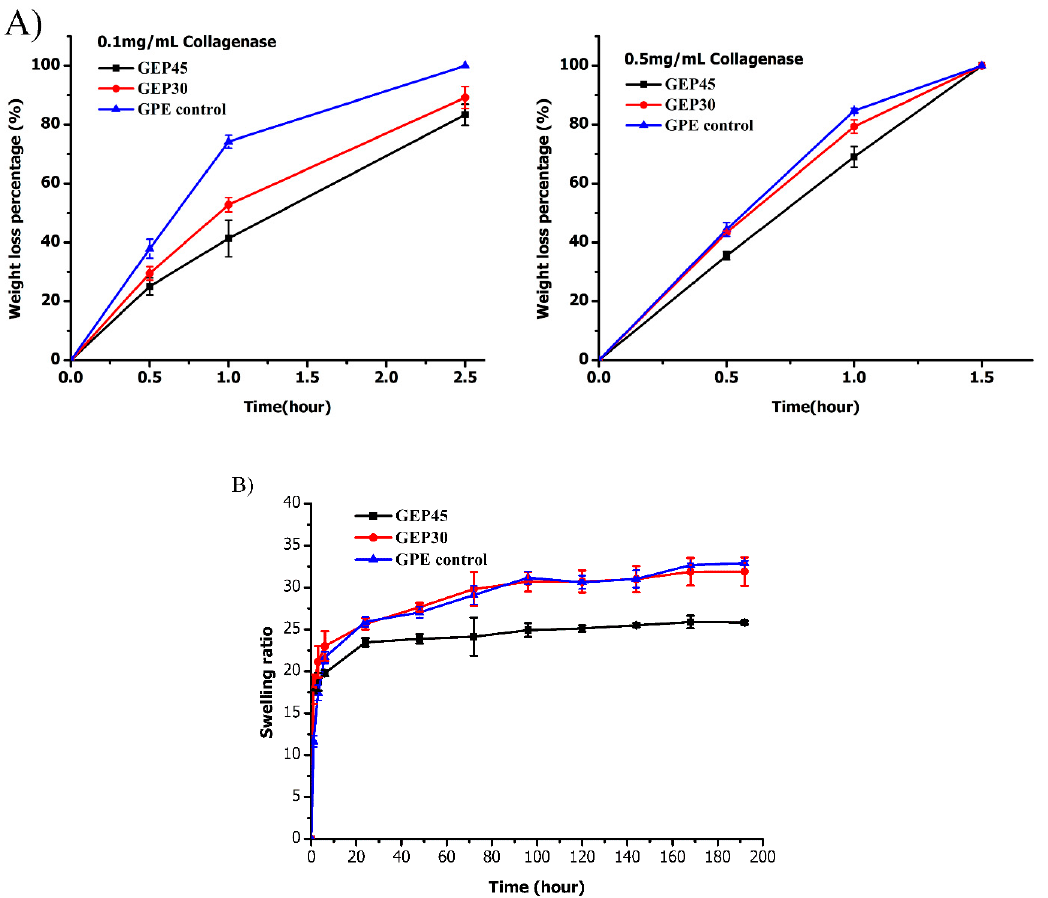
Figure 3. ( A ) Degradation kinetics of GEP45, GEP30 and GPE control in 0.1 mg/mL and 0.5 mg/mL collagenase solution. (n = 3); ( B ) Swelling profiles of GEP45, GEP30 and GPE control (n = 3). Table 3. The viscosities of GEP 30, GEP 45 and GPE control precursor at different shear rates. Samples